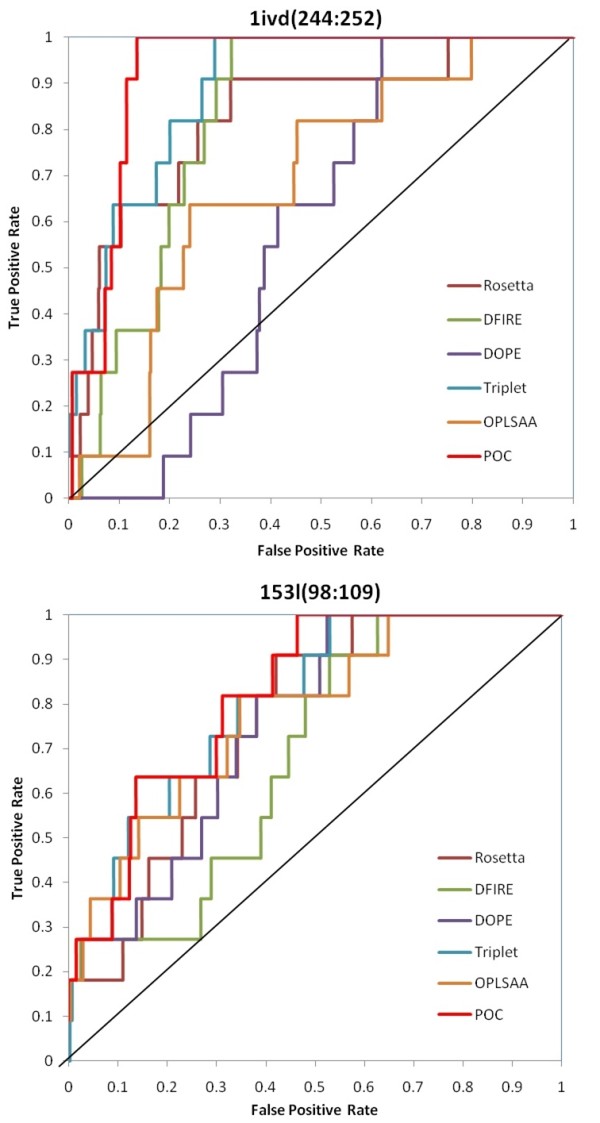
ROC Curves for Decoys in 1ivd(244:252) and 153 l(98:109). In these ROC curves, the true positives are the number of top-N ranked decoys with RMSD less than or equal to r, the false positives are the number of top-N ranked decoys with RMSD greater than r, the false negatives are the number of decoys with RMSD less than or equal to r but having rank greater than N, and the true negatives are the number of decoys with rank greater than N and RMSD greater than r. In our ROC plots, r is the 10th best RMSD in a decoy set and N is the cutoff variable. The ROC curves generated by the POC method yield higher AUC values than those of the individual scoring functions.